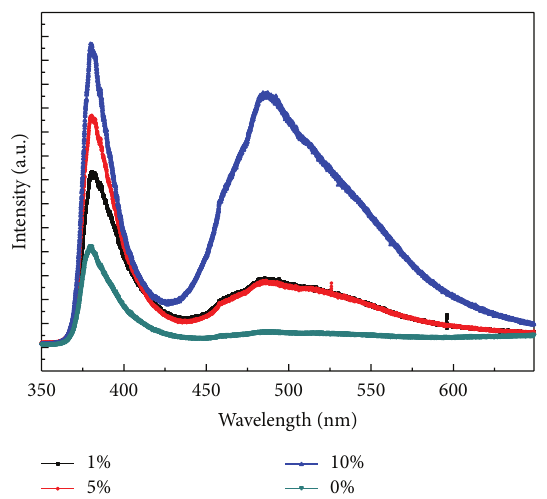
Figure 5: PL spectra of the ZnO thin films with different concen- trations of incorporated YAG at room temperature.